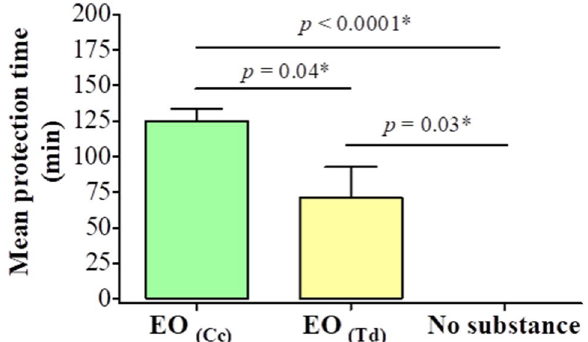
Figure 2. Mean protection time on field of the different substances tested. EO (Cc) : Essential oil of C. citratus (positive control); EO